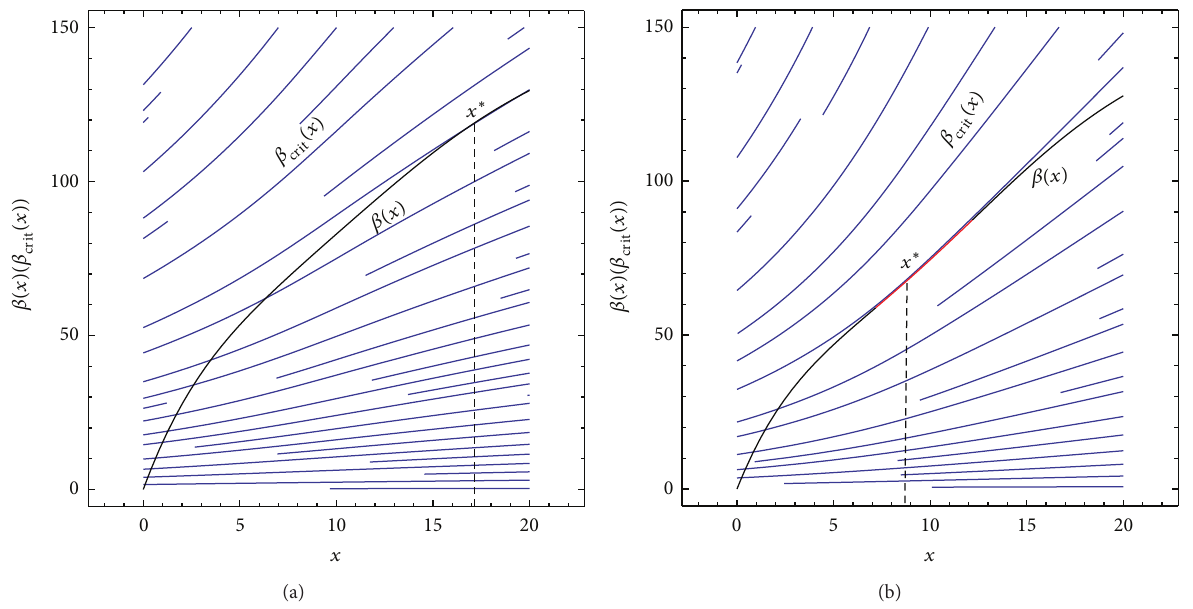
Figure 3: Critical function analysis (a)-(b), (a) 𝐾 = 0.2 , (b) 𝐾 = 0.3 ; black solid lines indicate the CSS, red solid line indicates convergence stable but not evolutionarily stable singular strategy 𝑥 ∗ (i.e., evolutionary branching point), and parameter values are 𝑎 = 200, 𝑏 = 10, 𝜇 = 6, 𝜎 = 10, 𝑐 = 2, V = 0.8, 𝜆 = 10.25 , and 𝑝 = 6 .